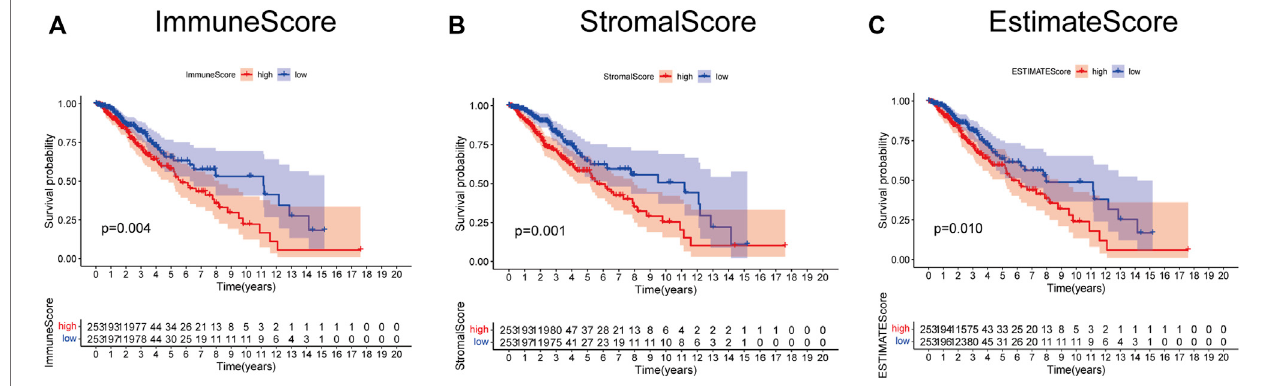
FIGURE 2| Survival analysis based on scores. Patients in the lowimmunescore (A) , stromal score (B) , and ESTIMATE score group (C) had better prognosisthan those in the corresponding high-score group.